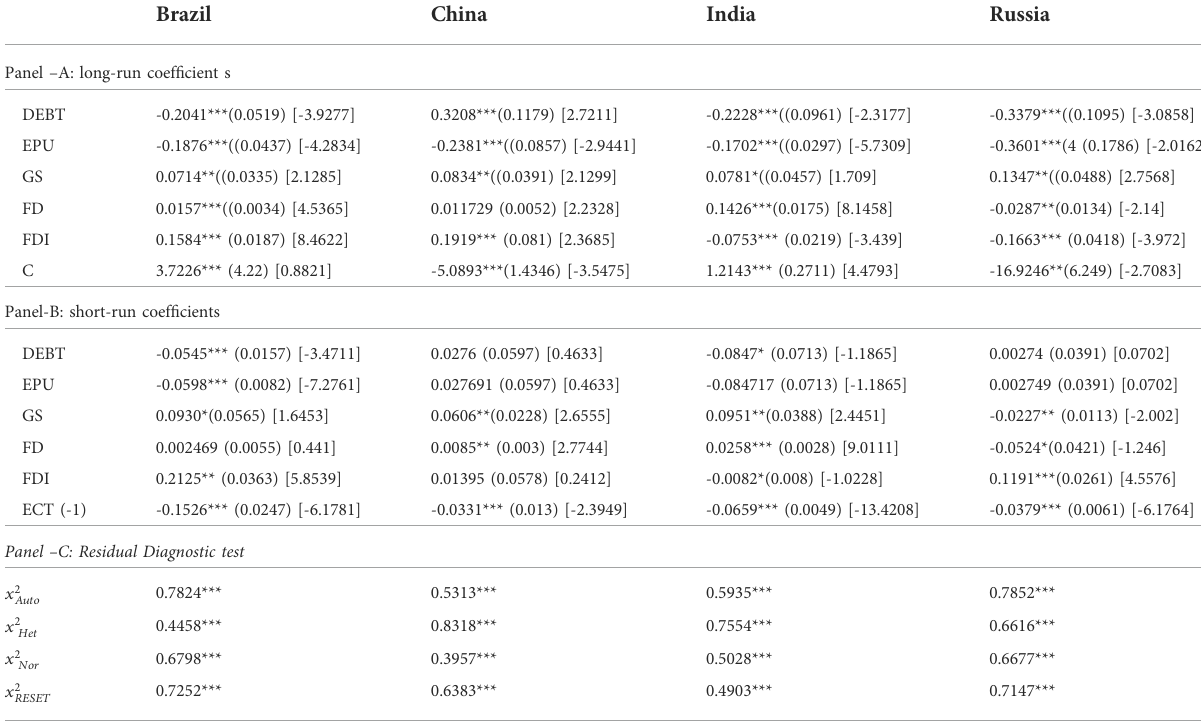
TABLE 6 Long-run and short-run coef fi cients of DEBT, EPU, GS, FD, and